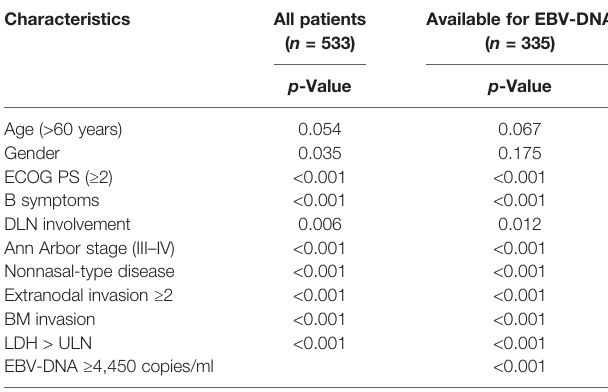
TABLE 3 | Multivariate analysis showing the association of variables with NK/T-LAHS.